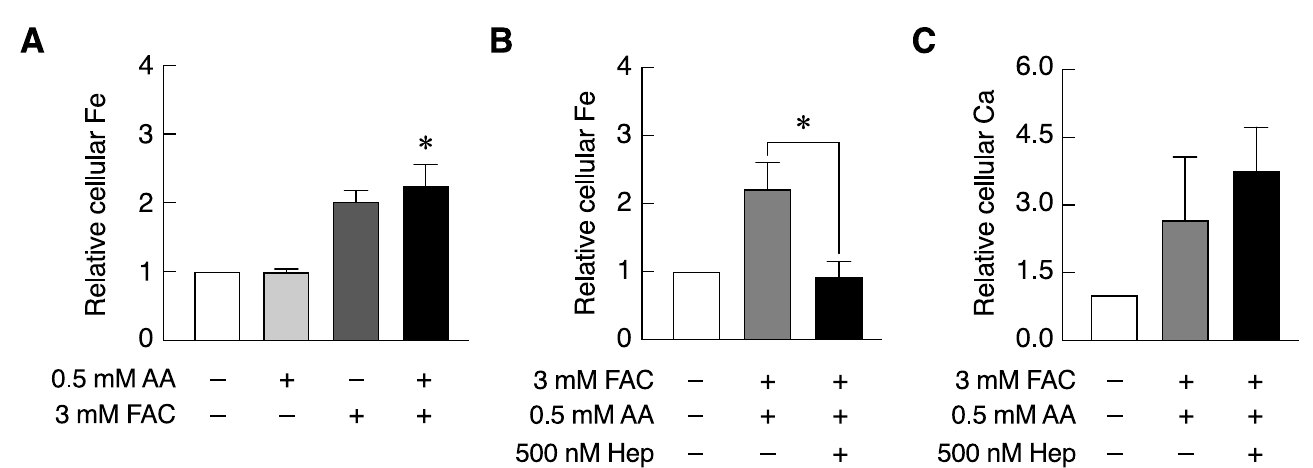
Fig 1. Ascorbic acid-enhanced intestinal cell iron uptake was significantly reduced by hepcidin. ( A ) Cellular iron in Caco-2 cells were measured by FAAS after exposed to 0.5 mM ascorbic acid, 3 mM FAC or their combination for 24 hours (n = 4), and ( B ) effects of hepcidin on cellular iron level under iron uptake stimulation was investigated in Caco-2 cells. The Caco-2 cells were pre-treated with 500 nM hepcidin for 6 hours and exposed to 3 mM FAC together with 0.5 mM ascorbic acid for 24 hours (n = 3). ( C ) Cellular calcium level from the same sample groups as shown in (B) were also measured by FAAS (n = 3). Data was analyzed from at least three independent biological experiments as indicated (n). P -value was calculated using the Kruskal-Willis with Dunn’s Multiple Comparison Test or one-tailed Mann-Whitney U Test. � P < 0.05 as compared to untreated sample.